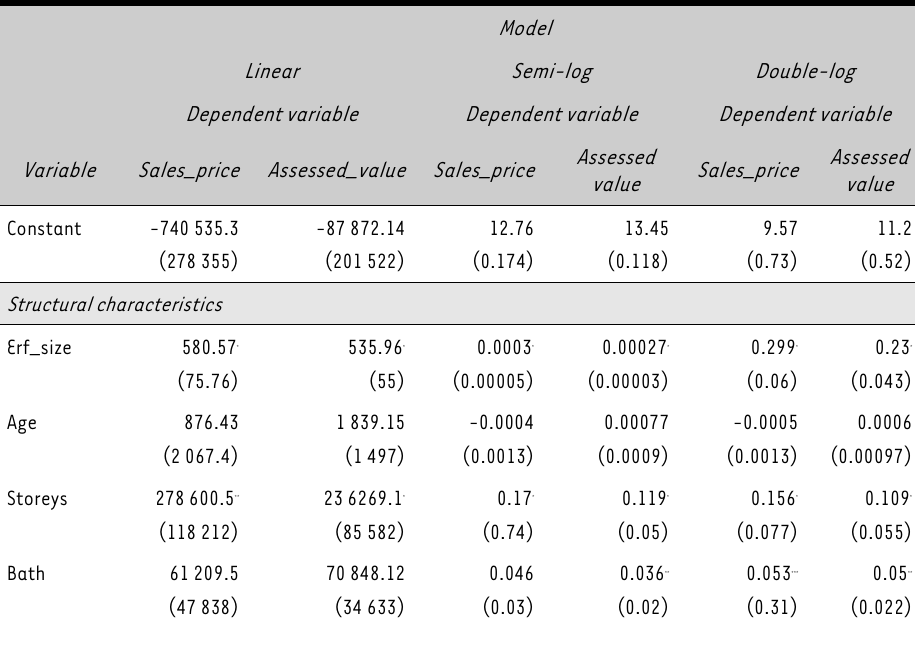
FIGURE 3: Assessed value distribution TABLE 2 presents the results of the SUR. In the estimation of the SUR model, m = 1 represented the equation with sales prices as the dependent variable and m = 2 represented the equation with assessed values as the dependent variable (see Equation 3). Three model specifications were estimated, namely the linear, semi-log, and double-log. This allows for goodness-of-fit comparisons based on R-squared values. All models were estimated using Stata Version 11.0. Estimation results for the SUR (standard errors in parentheses 1